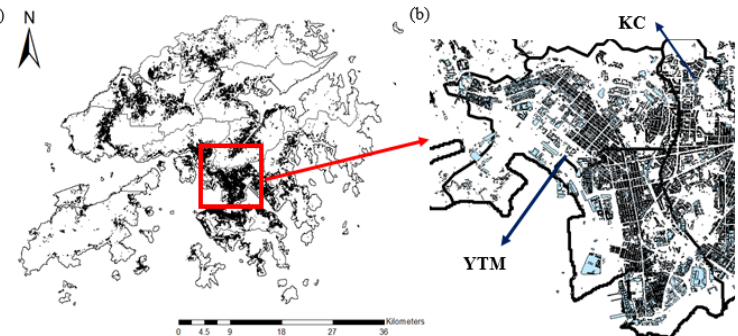
Figure 1. ( a ) The spatial distribution of buildings and podiums within 18 districts of Hong Kong; ( b ) the enlarged top plain view of the red square box in Figure 1a—precisely the Yau Tsim Mong (YTM) District and part of the neighboring Kowloon City (KC) District. Buildings and podiums are shaded in pale blue.